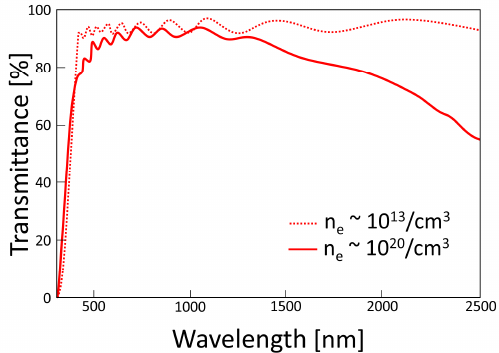
Figure 1. Optical transmission spectrum of the a-IGZO device for two different concentrations. A dashed line is n e ~ 10 13 / cm 3 and a solid line is n e ~ 10 20 / cm 3 . Here, significant decrease of the transmittance of long wavelength light is found for the higher carrier concentration case (redrawn and adapted from [24] ).